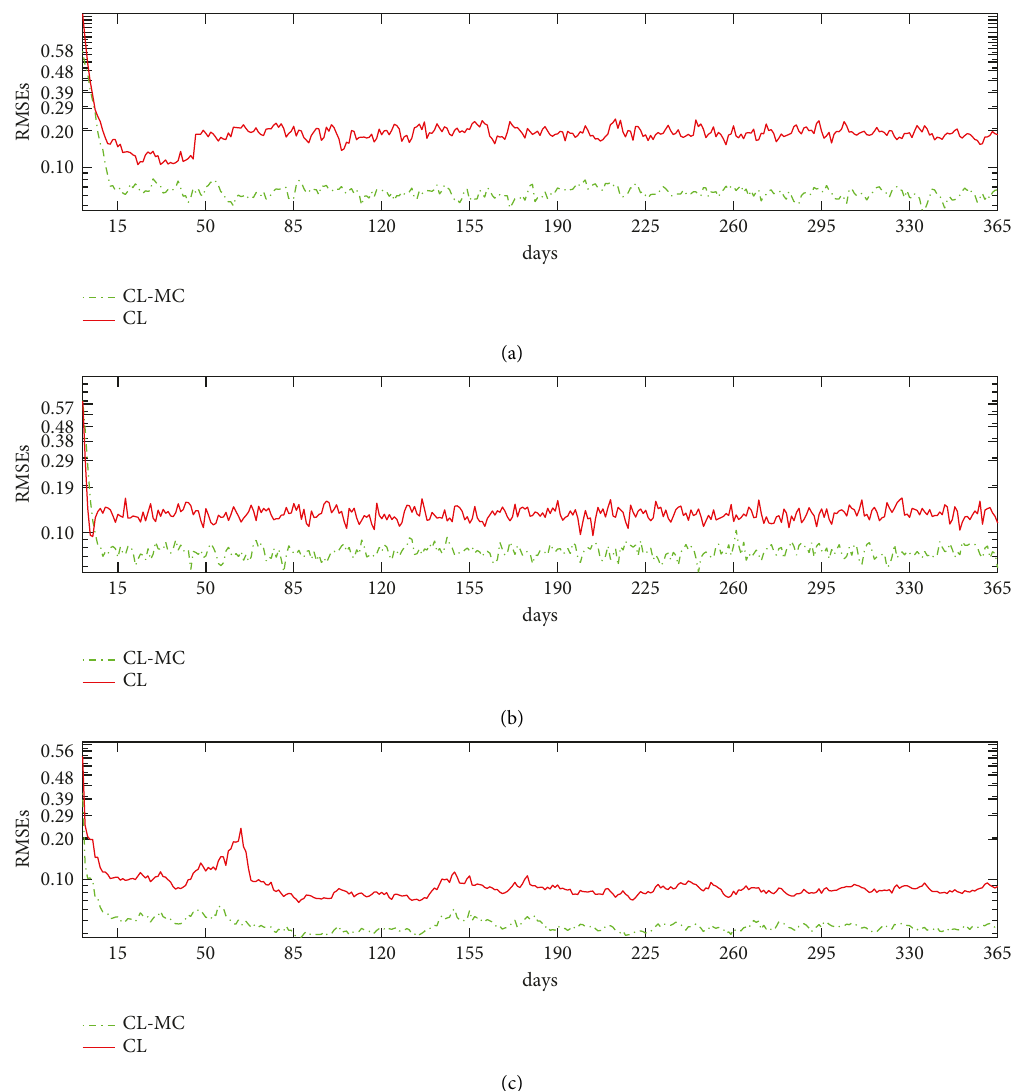
Figure 4: Experiment with the Lorenz-96 model. The time series of RMSEs for the CL and CL-MC methods with the localization radii are (a) localization radius � 10, (b) localization radius � 15, and (c) localization radius � 20,